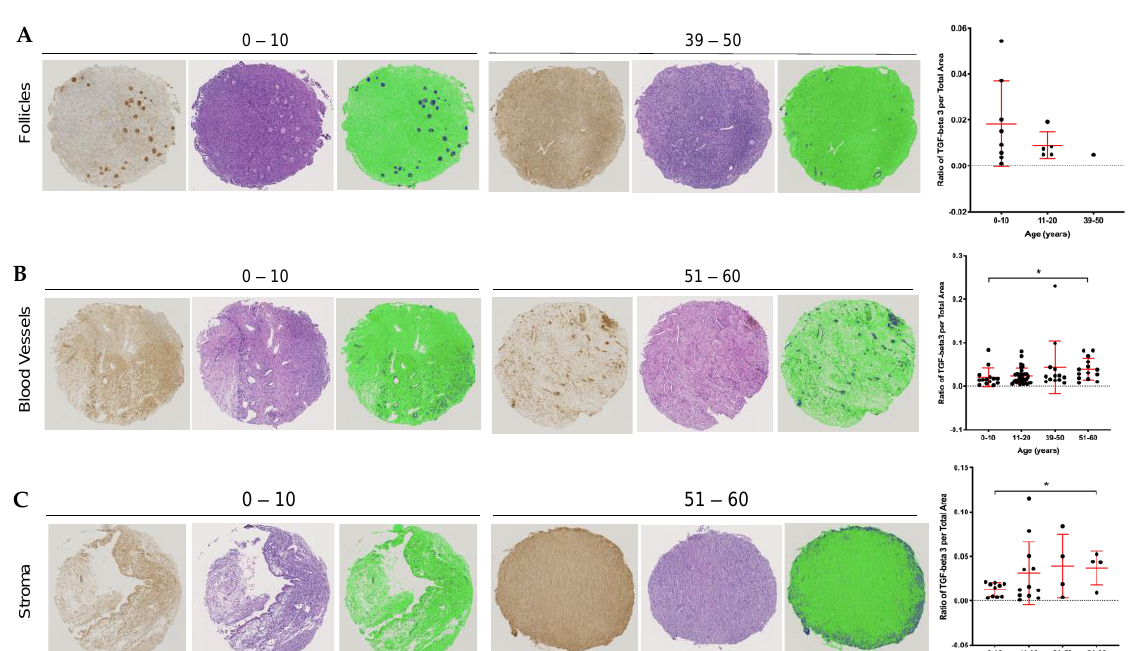
Figure 7. Analysis of ovarian cores from the TMA reveal changes in TGFβ3 content with age depending on the presence of landmark tissue structures. Each core was categorized into one of three major tissue structures: follicles, blood vessels or stroma. Representative images of youngest and oldest age cohort’s cores are shown with the first panel: TGFβ3 staining in the brown, middle panel: hematoxylin and eosin stain and last panel: quantitative data measurement with positive TGFβ3 signal in dark blue and negative TGFβ3 stain in green. ( A ) Average core 1 and 2 ratios of TGFβ3 per total area across age cohorts with follicles. ( B ) Average core 1 and 2 ratios of TGFβ3 per total area across age cohorts with blood vessels. ( C ) Average core 1 and 2 ratios of TGFβ3 per total area across age cohorts with stroma. Asterisks (*) indicate statistical significance with panel ( B ) p = 0.04 and panel ( C ) p = 0.004.